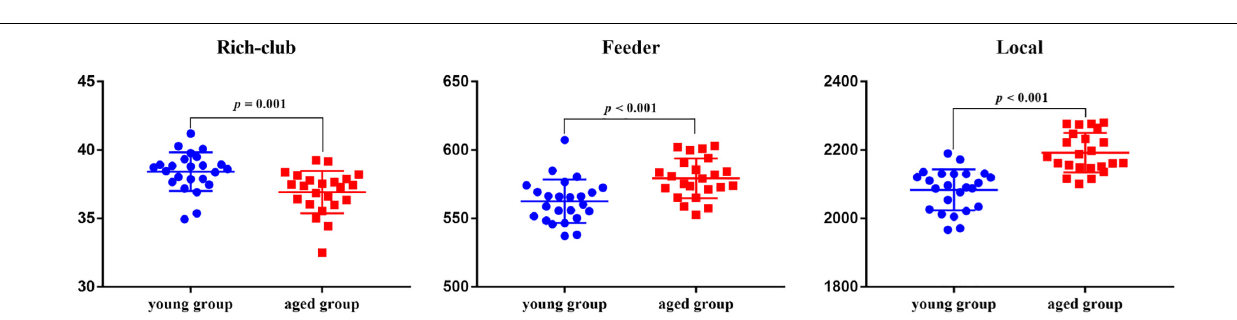
was significantly reduced ( p = 0.001) in the aged rats, while the overall strength of feeder and local connections was significantly increased ( p <